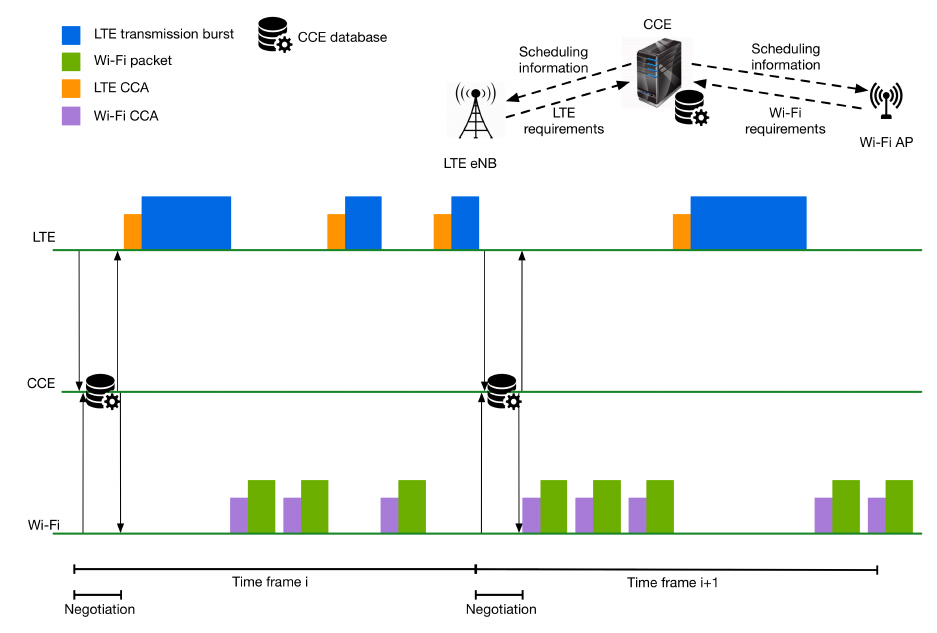
Figure 15. Negotiation phase between LTE and Wi-Fi and timeslot